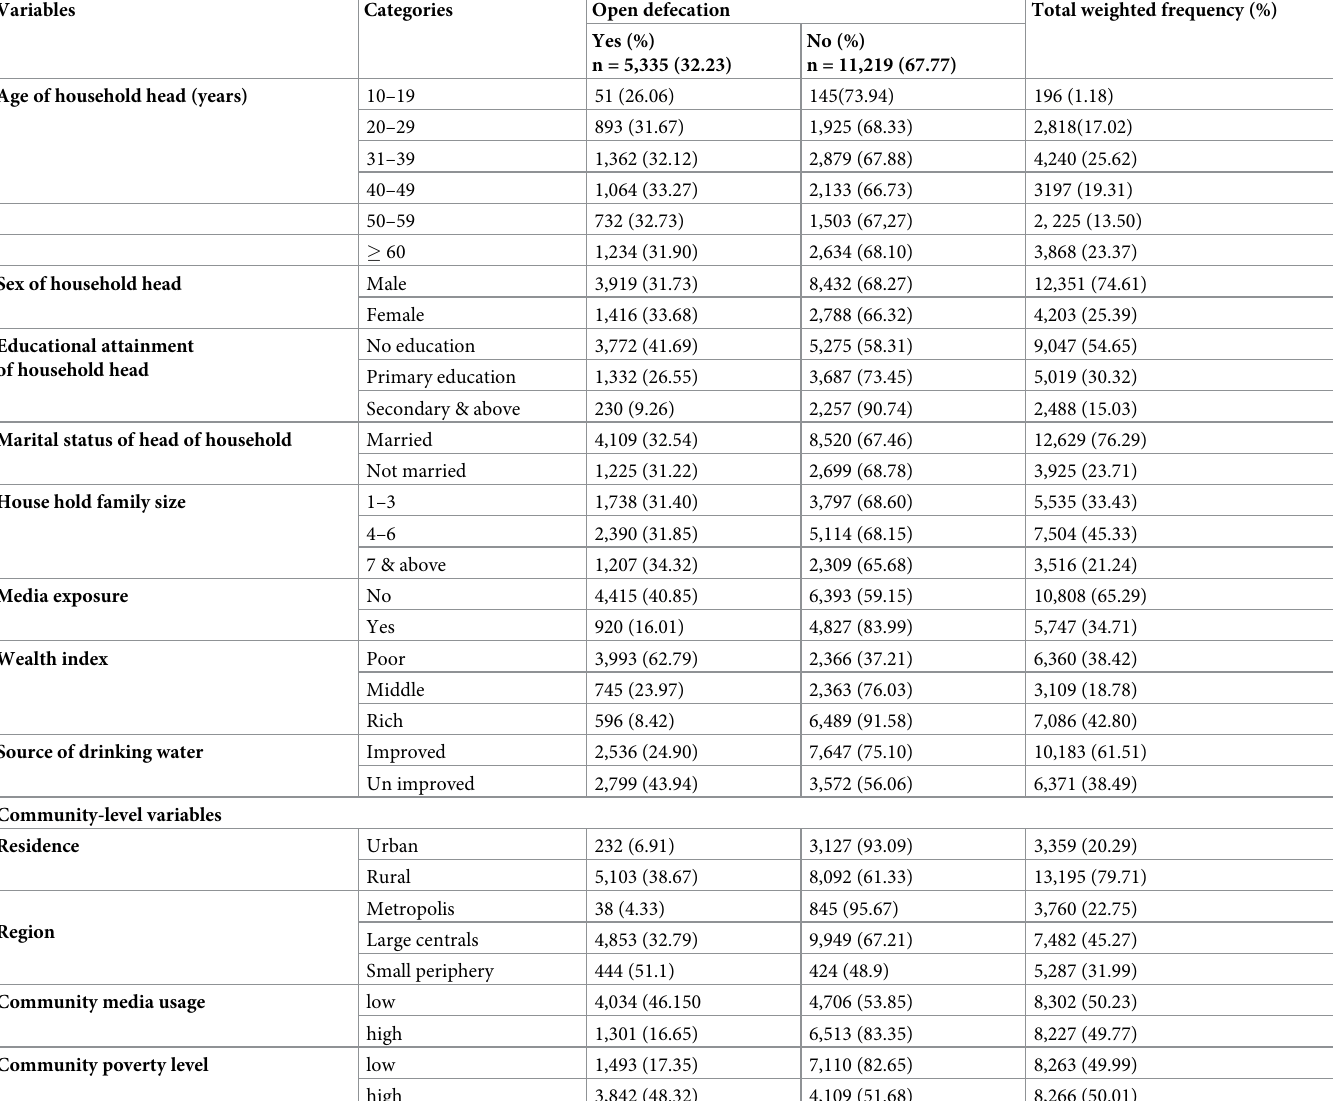
Table 1. Socio-demographic characteristics of the study population with open defecation usage in Ethiopia, 2016